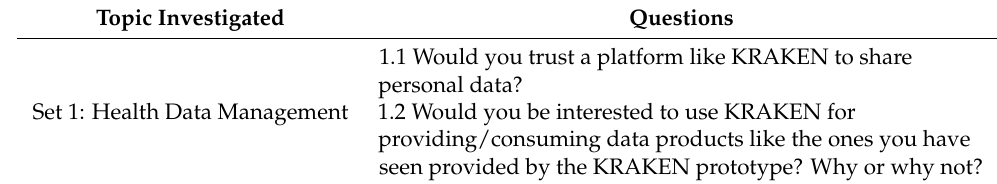
Table 1. Questions posed to participants attending the health pilot evaluation.